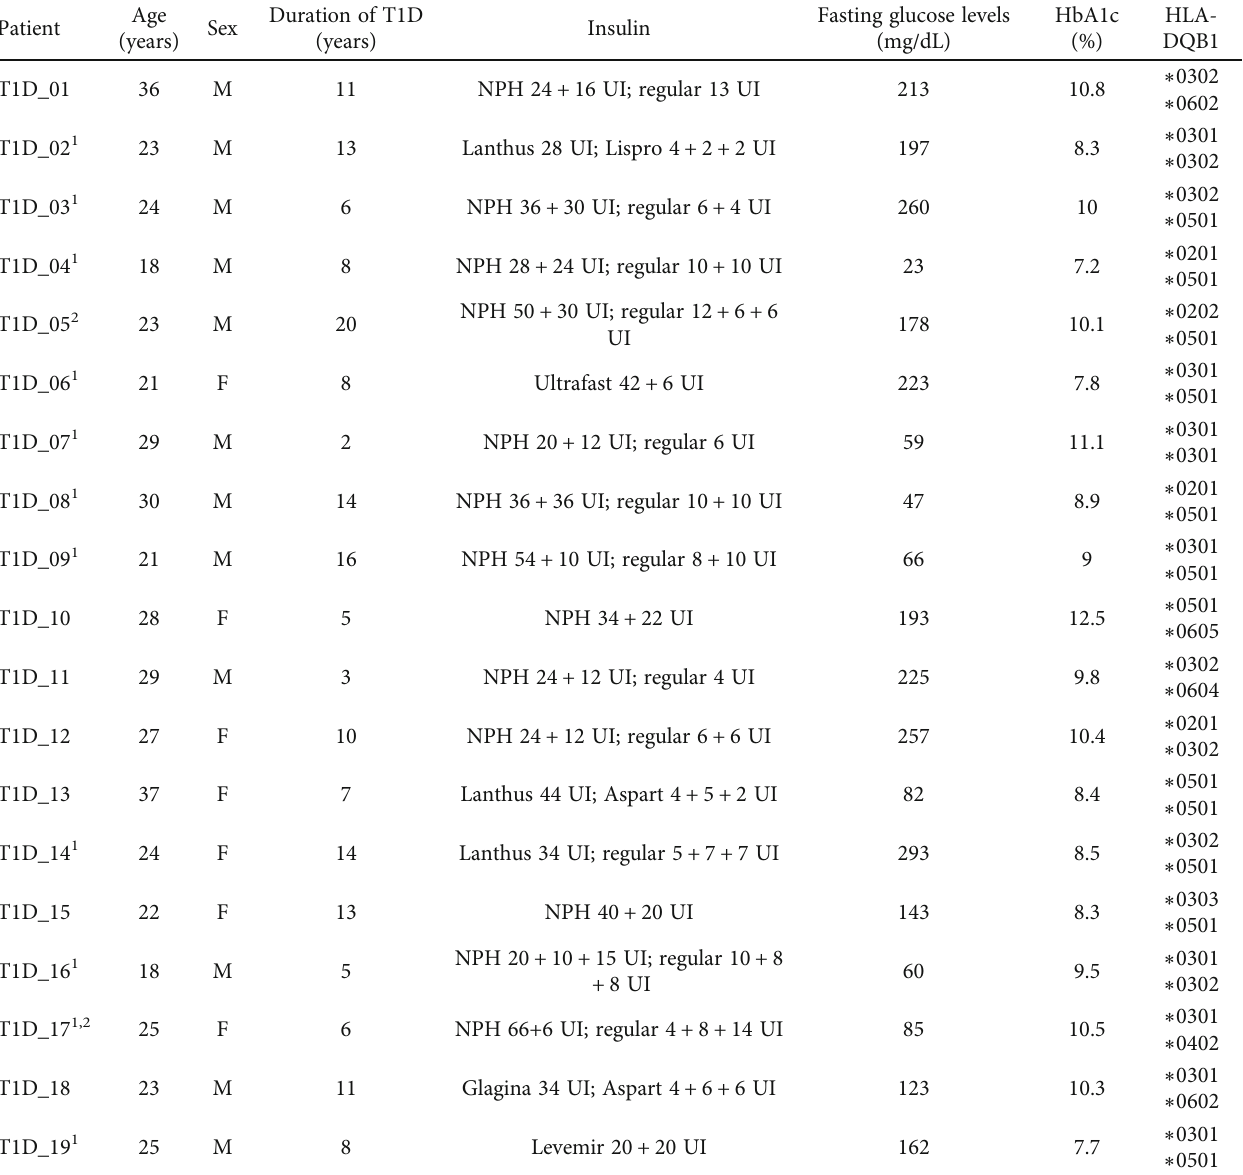
Table 1: Main clinical characteristics of type 1 diabetes (T1D)